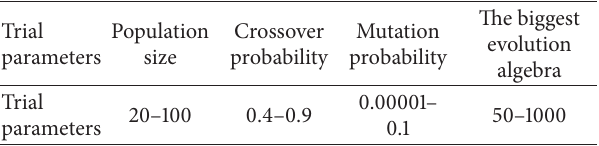
Table 1: Genetic algorithm (GA) trial scope commonly used